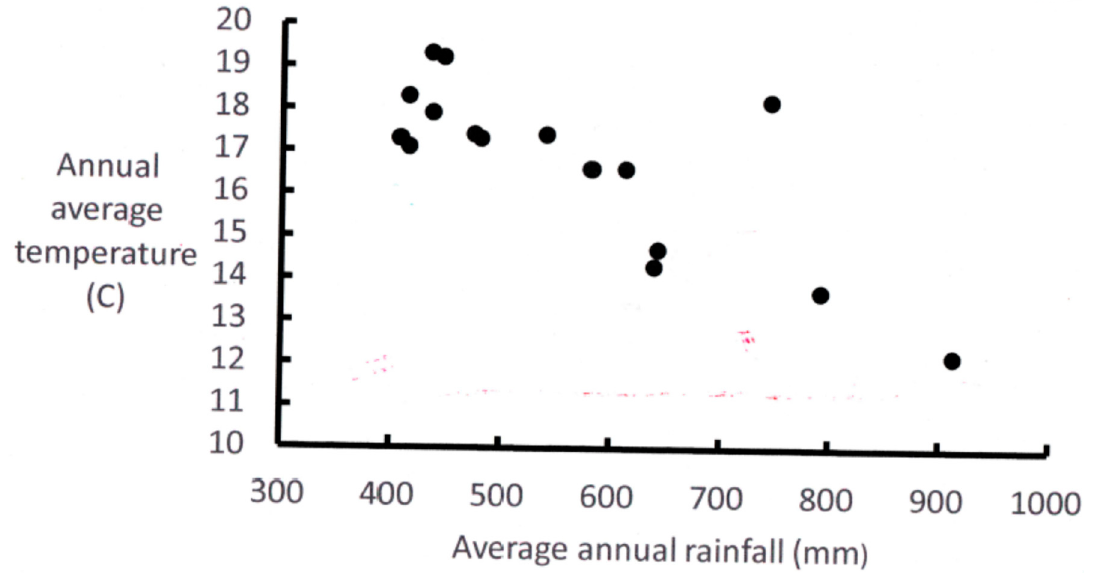
Figure 3. Average annual temperature and average annual rainfall for sites used in study. Table 2. Site details. GO is Australian Greenhouse Office set of profiles. LR is Little River set of profiles. MAR is mean annual rainfall. MAT is mean annual temperature.